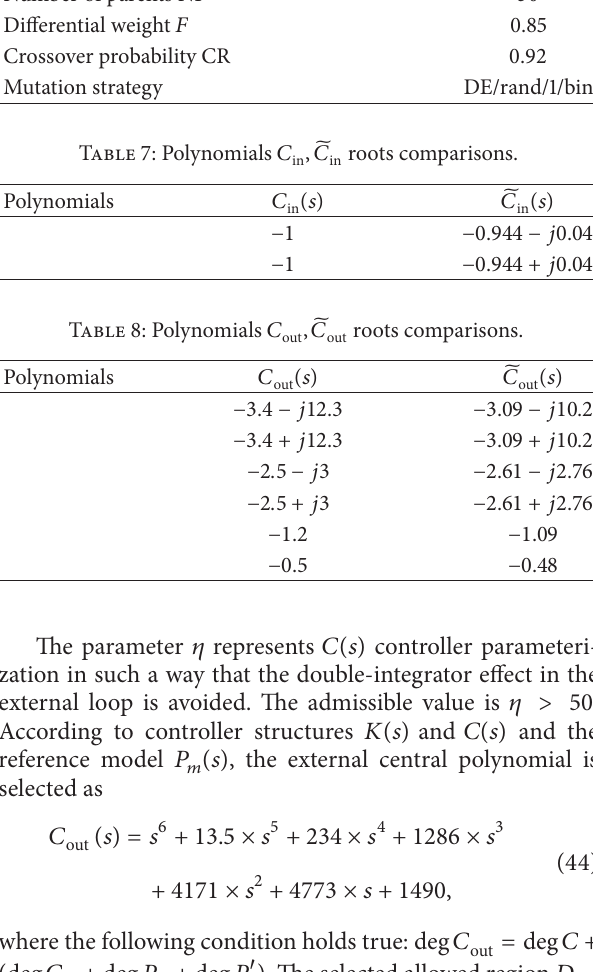
Figure 11: Output of the controller 𝐾(𝑠)